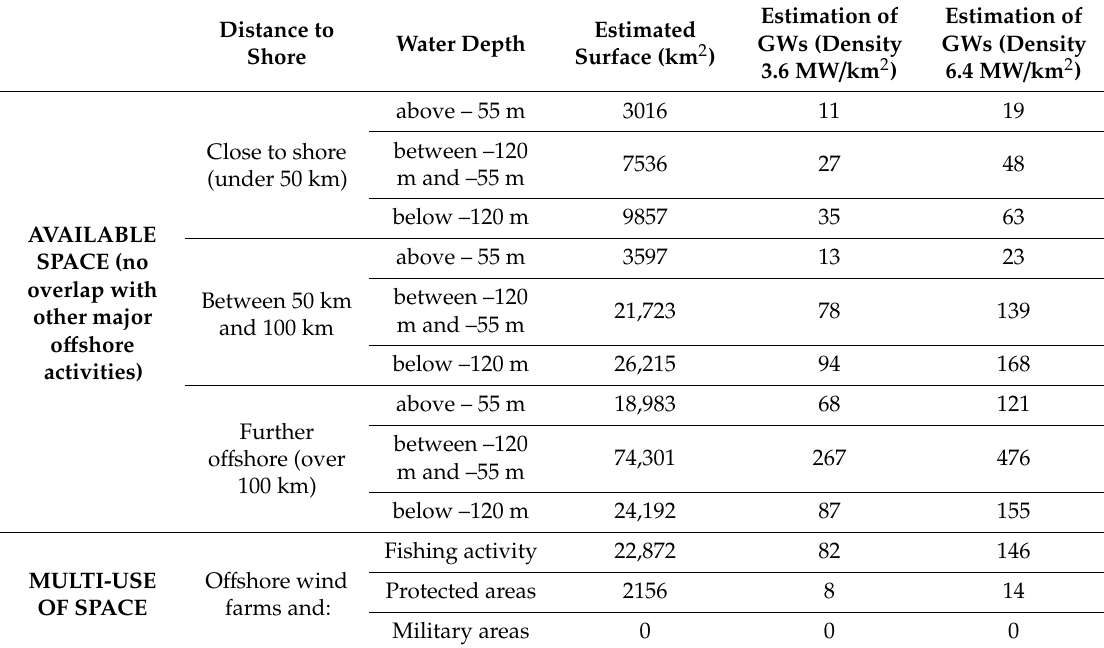
Table 9. Available space—Scenario